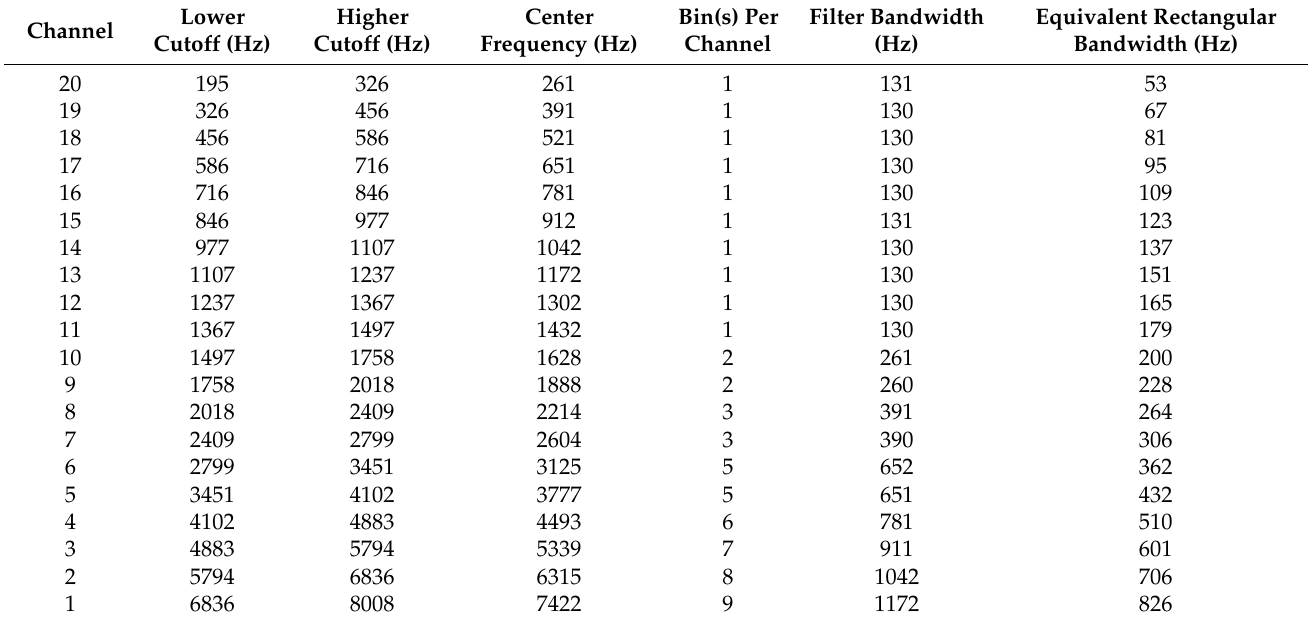
Table 1. Centre and cutoff frequencies of the vocoder. Number of bins (FFT coefficients) per channel. Lower Cutoff Channel